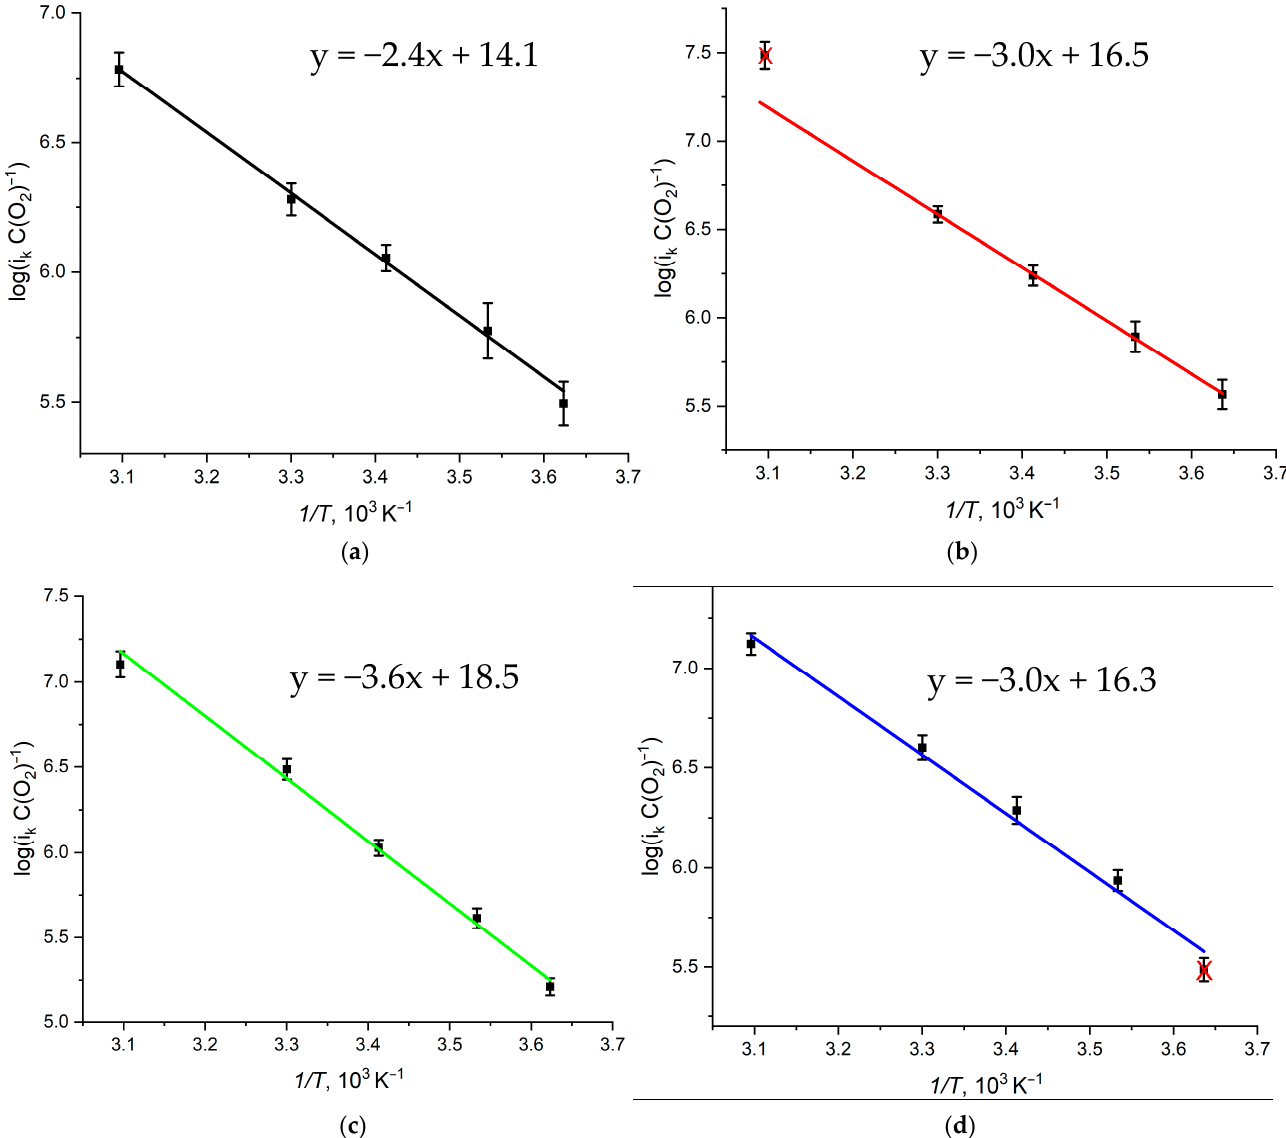
Figure 8. Arrhenius plots for the ORR in 0.1 M HClO 4 for the samples: Pt 40 /C ( a ) Pt 20 /C ( b ) Pt 20 SnO 25 /C ( c ) Pt 20 SnO 210 /C ( d ). The mass transfer is adjusted, the currents are normalized to the concentration of dissolved oxygen.